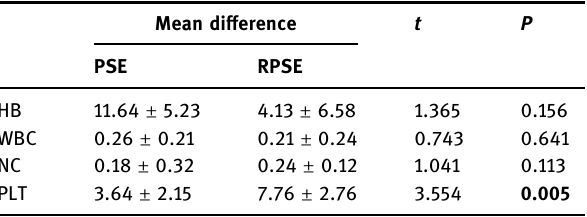
Table 6: Comparison of hematological index between fi rst and second mean di ff erence splenic embolization Mean di ff